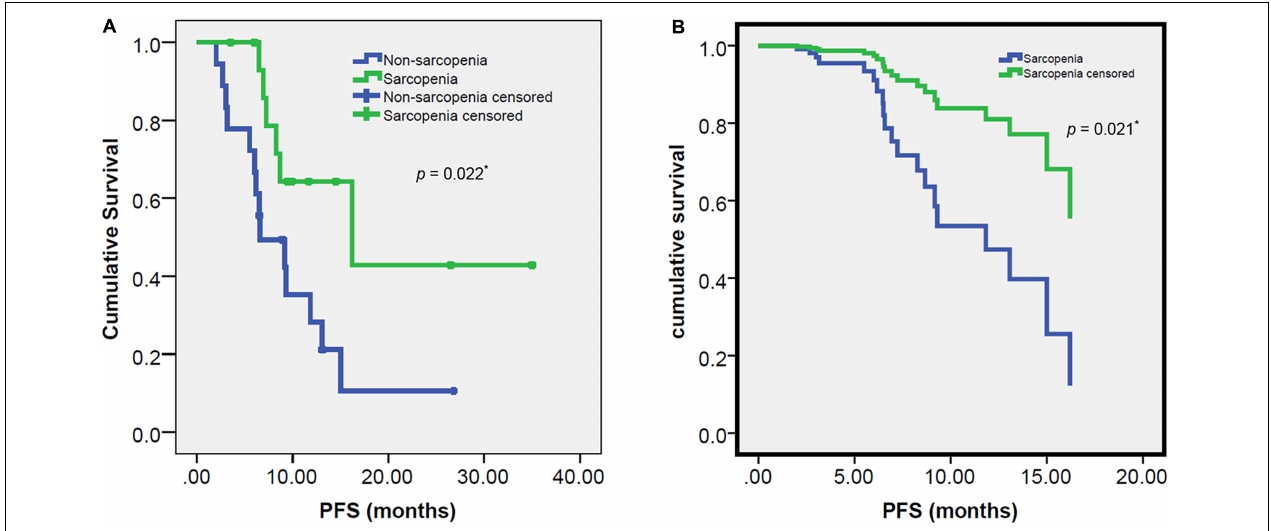
FIGURE 3 | Progression free survival (PFS) survival curves: estimated by Kaplan-Meier method and log-rank test (A) and estimated by multivariate analysis of Cox proportional hazards regression model (B) for the sarcopenia and non-sarcopenia groups. The PFS was significantly worse in the sarcopenia group than the non-sarcopenia group (6.57 vs. 16.2 months, p = 0.022, 0.021, respectively). *Indicates significant difference.